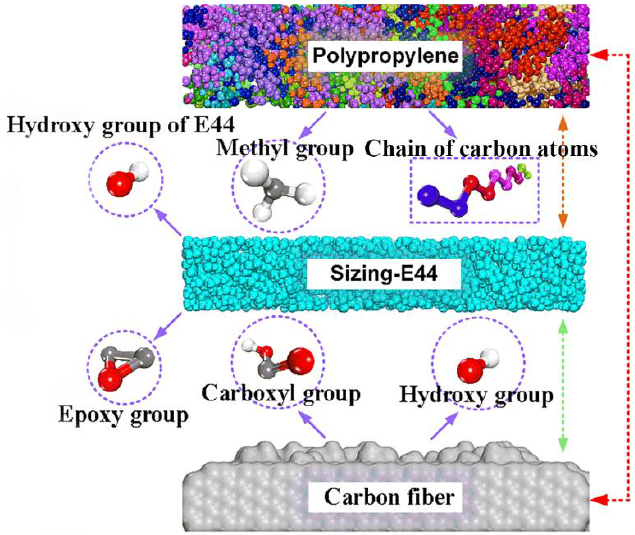
Figure 8. Schematic diagram of main atomic groups at the CF – PP interface.